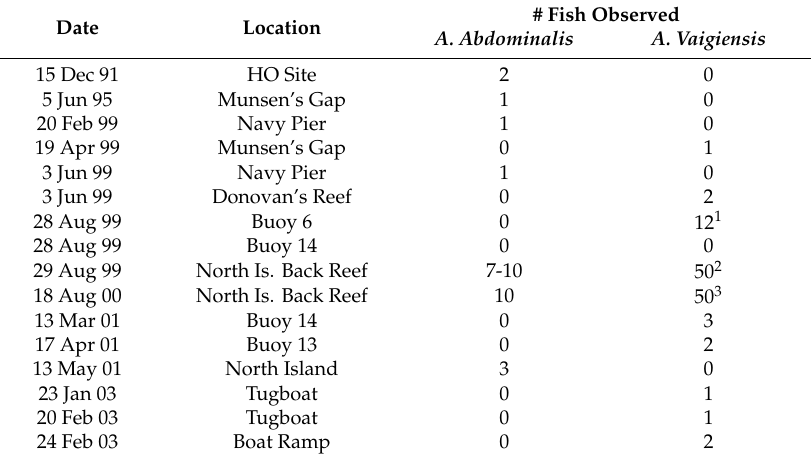
Table 2. Abudefduf species colonization chronology.